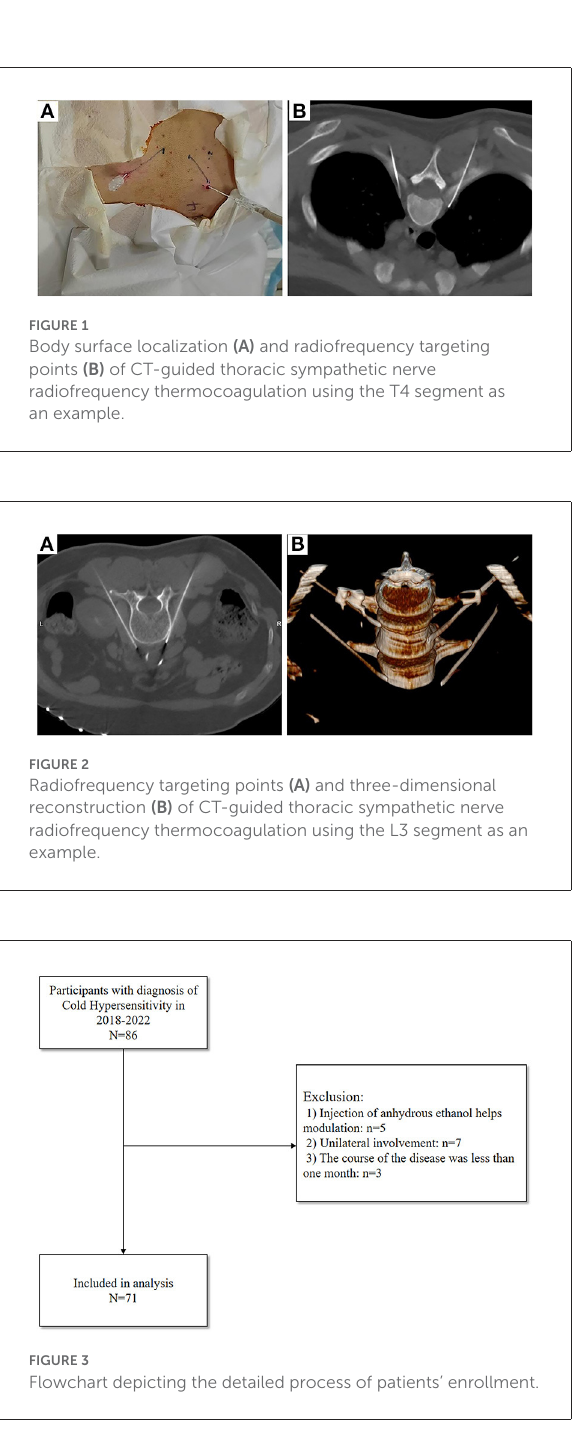
after back pumping free of fluid and gas. Sensory testing at 50Hz and 0.2-1.0 mA and motor testing at 2Hz and 1.0 mA max were performed through the radiofrequency machine. Confirmation of the absence of muscle twitching in the area of spinal nerve innervation indicated the feasibility of RF